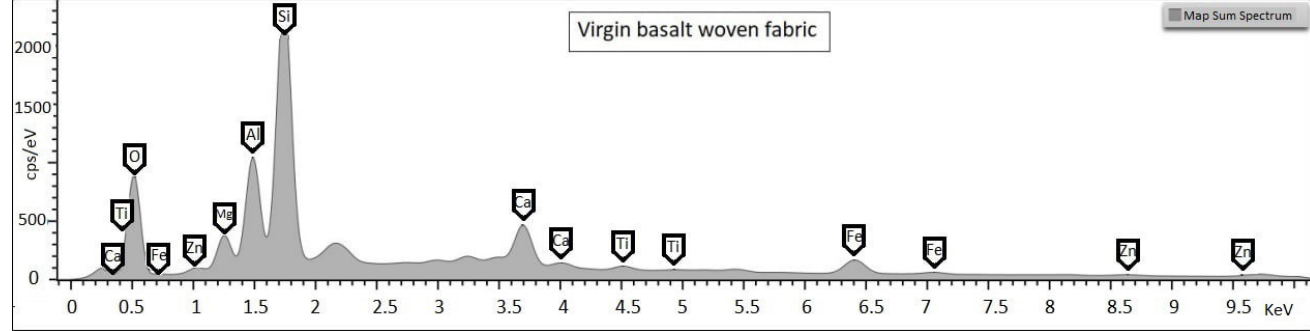
Figure 17. Virgin basalt woven fabric EDS